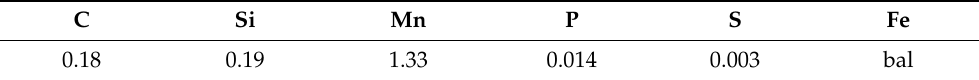
Table 1. Chemical compositions of carbon steel plate (wt%).